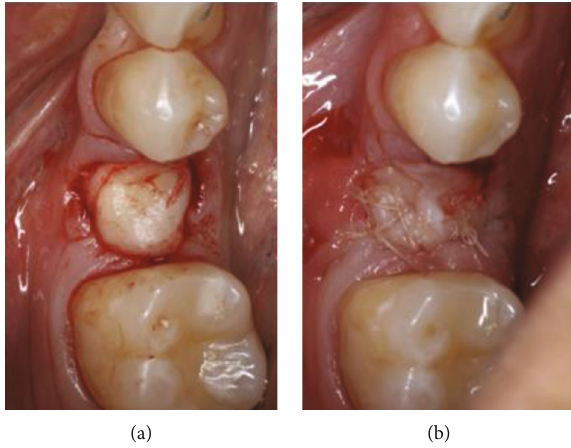
Figure 4: (a) Placement of the graft in the socket; (b) graft stabilized with 6/0 absorbable